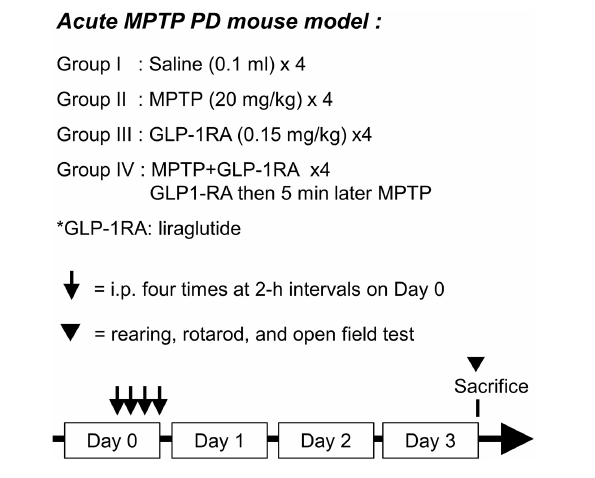
FIGURE 1 | Schematic diagram of experimental design. Acute MPTP PD mouse model was used with 8-week-old C57BL/6 mice. The mice were allocated into four groups with the following treatments applied through intraperitoneal (ip) injection: group I, 0.1 ml of normal saline; group II, 20 mg/kg of MPTP; group III, 0.15 mg/kg of a GLP-1RA (liraglutide); group IV, co-treated with 0.15 mg/kg of the GLP-1RA then 5 min later 20 mg/kg of MPTP. This dose was repeated four times at 2-h intervals on Day 0. Three days after administration of the last dose, mice were subject to neurobehavior tests and then sacrificed. The substantia nigra was extracted for further experiments. GLP-1RA, glucagon-like peptide-1 receptor